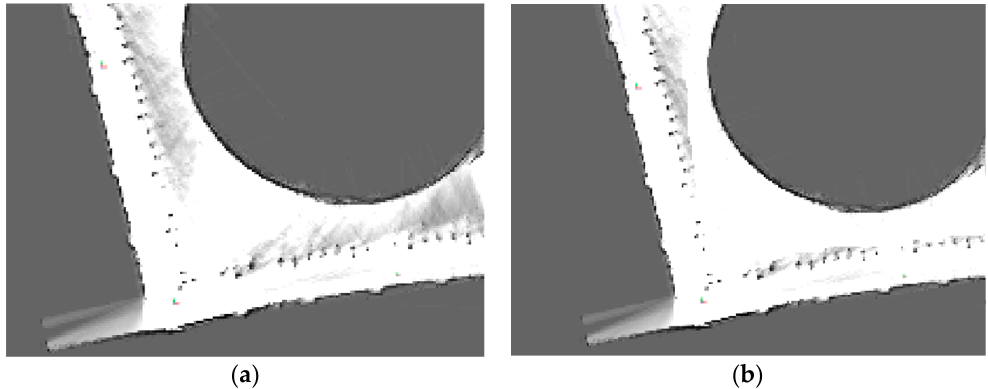
Figure 6. The edge and wall representation in a grid map (the more blurriness in a map, the lower quality it is). ( a ) A submap with more blurries (lower quality); ( b ) A submap with less blurries (higher quality).